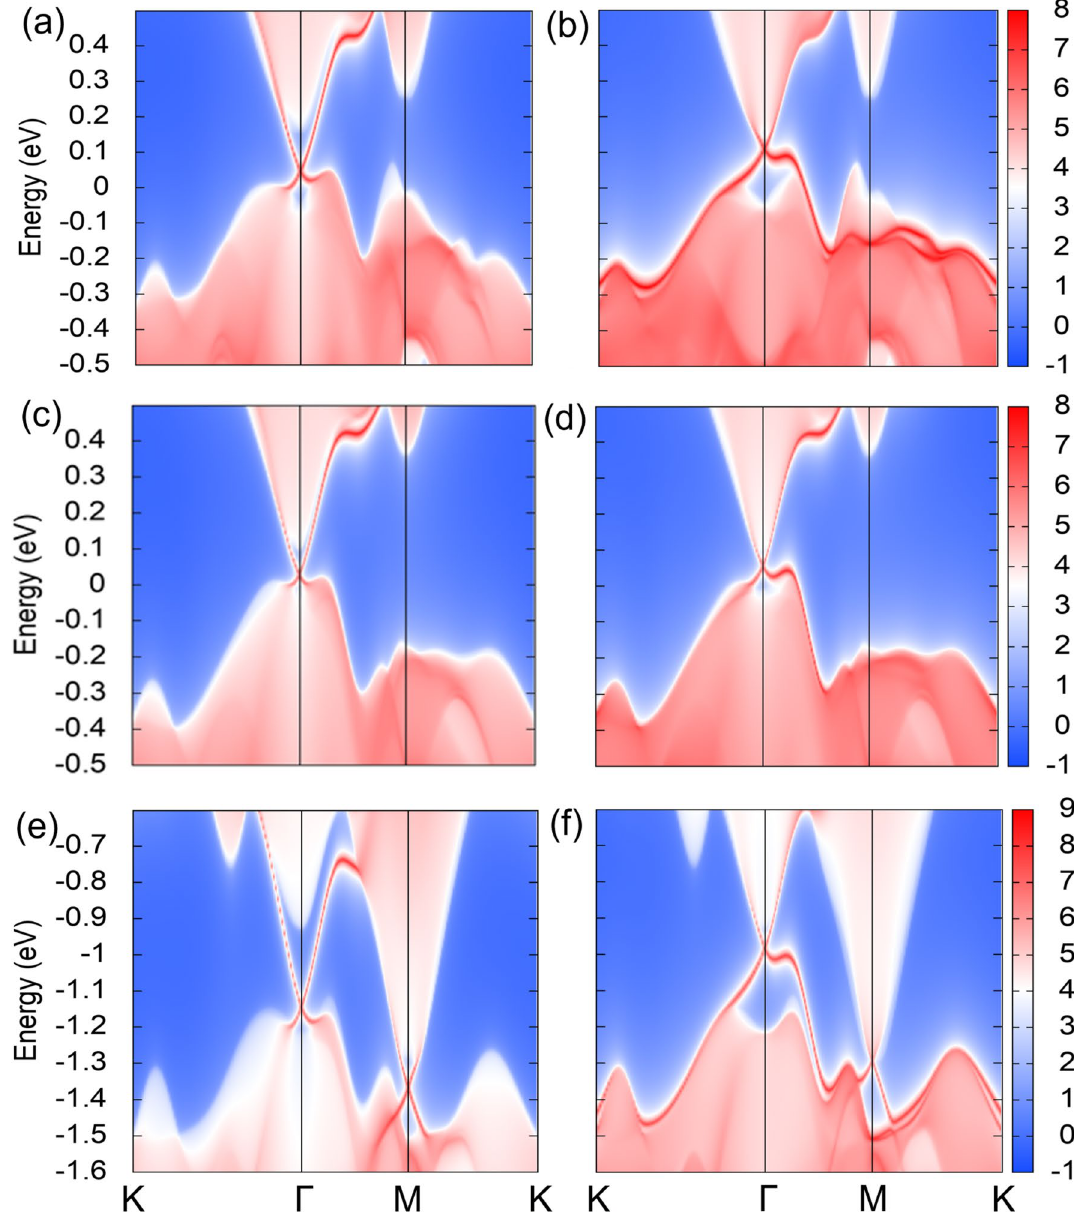
Figure 4. Surface states for the left surface of TlBiSe 2 , GaBiSe 2 and PbBiSe 2 are shown in ( a ), ( c ), ( e ) and for the right surface are shown in ( b ), ( d ), ( f ), respectively. Here, the sharp red curves represent surface states, whereas, the shaded regions show the spectral weight of projected bulk